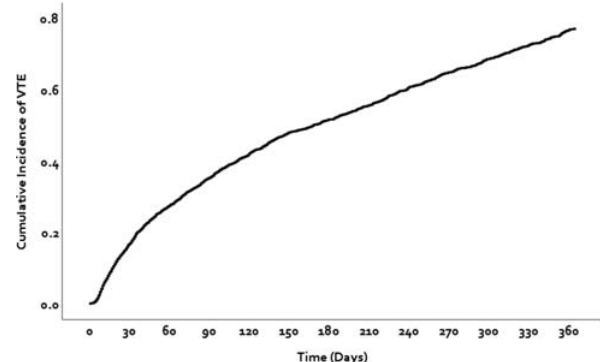
Fig. 2 Kaplan-Meier curve for time-to- fi rst venous thromboembo- lism. VTE, venous thromboembolism.